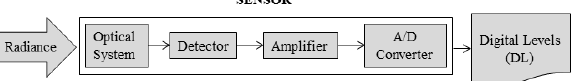
Figure 1. Process followed by radiation inside a